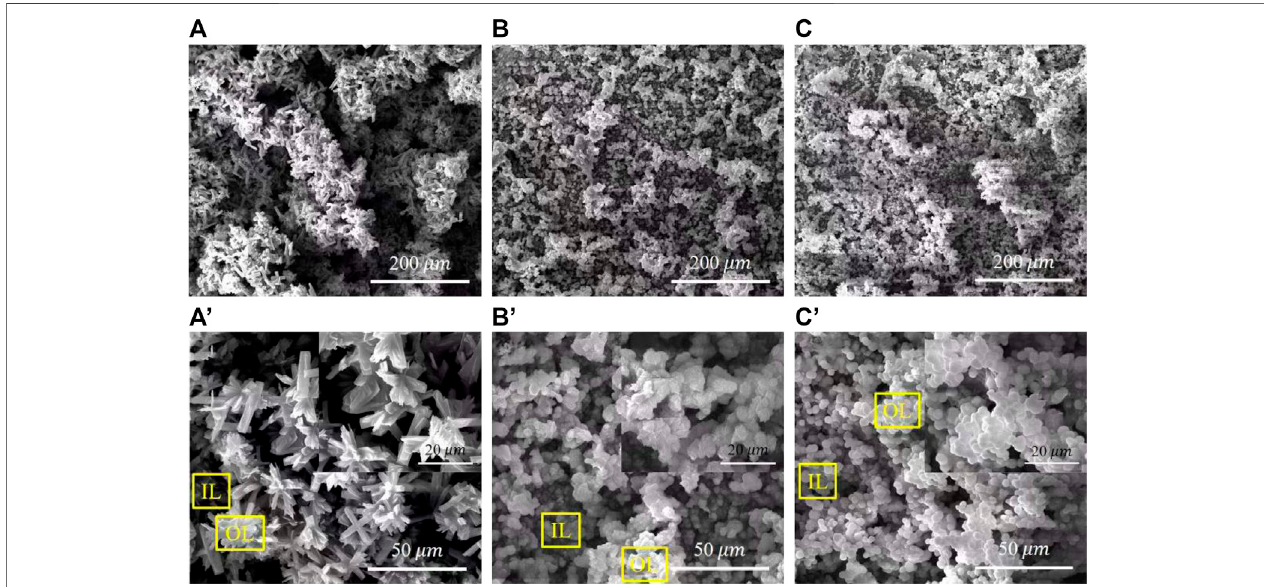
FIGURE 3| SEM images ofvarious pH values treated sampleswith different magni fi cation: (A,A ’ ) the pH 5.5-treated, (B,B ’ ) the pH 8.5-treated, and (C,C ’ ) the pH 11.5-treated.